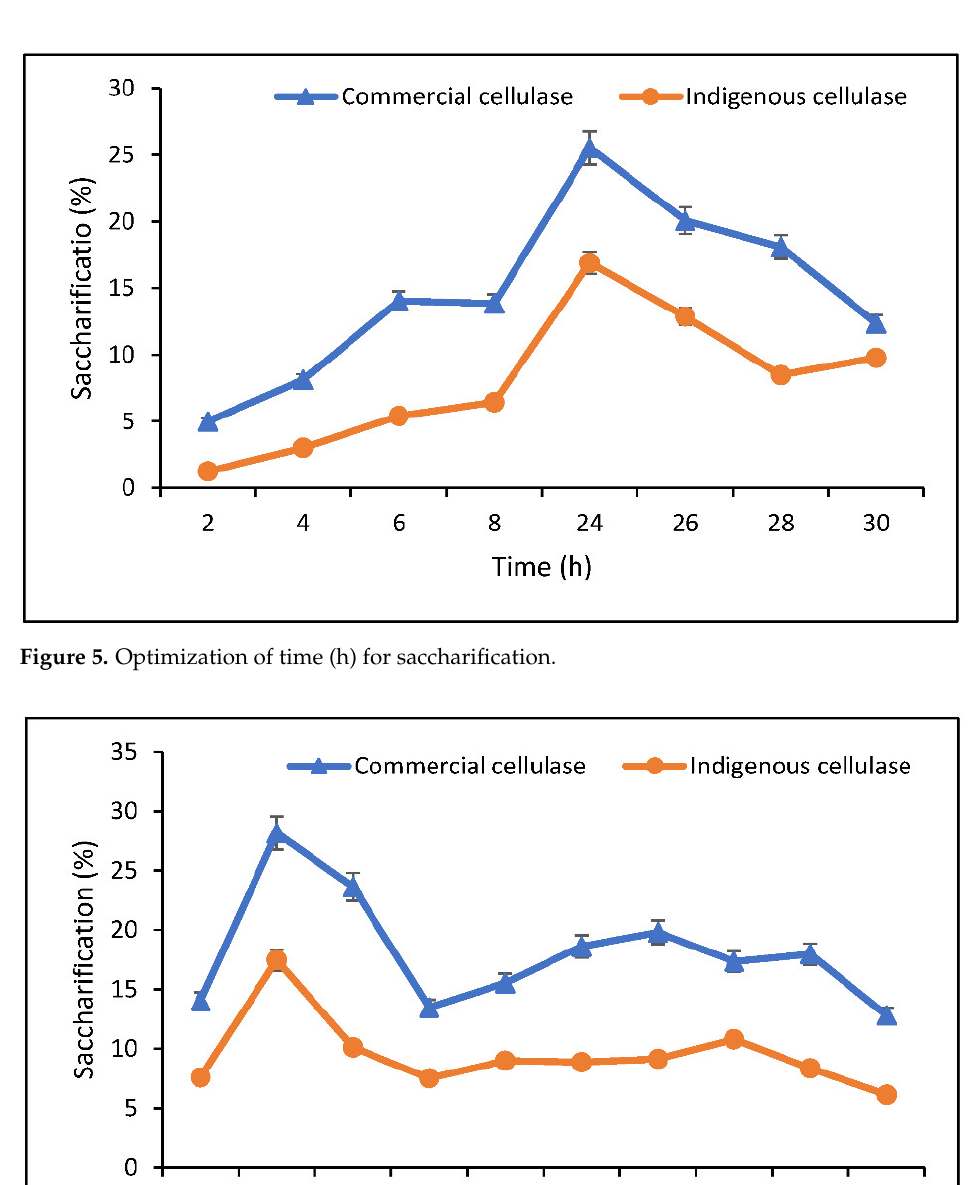
Figure 6. Optimization of substrate concentration (%) for saccharification. In the case of optimization of enzyme concentration, maximum saccharifications of 43% and 25.8% were found at FPU 40 IU/mL of commercial cellulase and 100 IU/mL of indigenous cellulase, respectively. Beyond these optimal conditions a distinct decline in saccharification (%) was noticed (Figure 7). In other research, the optimized conditions observed for maximum saccharification (40.15%) of wheat straw were 2% wheat straw, 0.5% cellulase loading, and a time period of 6 h [9]. Sindhu et al. [34] used BBD for optimizing hydrolysis and obtained maximum RS (0.651 g/g) at 11.25% ( w/w ) of substrate concentration, 50 FPU of commercial cellulase, and an incubation period of 42 h. Asghar et al. [35] obtained maximum hydrolysis (52.93%) with 2.5% biomass loading, 0.5% enzyme loading, and an incubation period of 8 h at 50 ◦